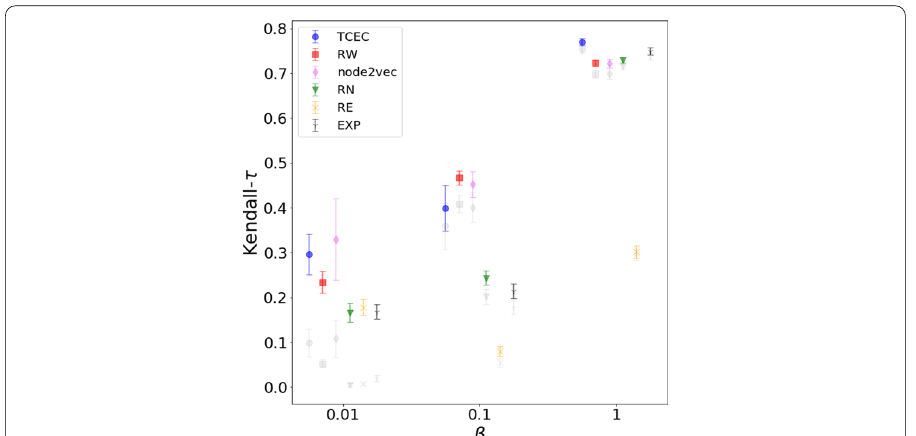
Fig. 7 Kendall- τ correlation between SpringRank scores inferred on samples and full graph, generated with the SpringRank generative model for varying level of inverse temperature β . Scores with respect to ground truth SpringRank scores are represented in shaded gray. Standard deviations are computed across 10 rounds of sampling. Notice that here EXP has variance, as in these experiments we varied the initial seed